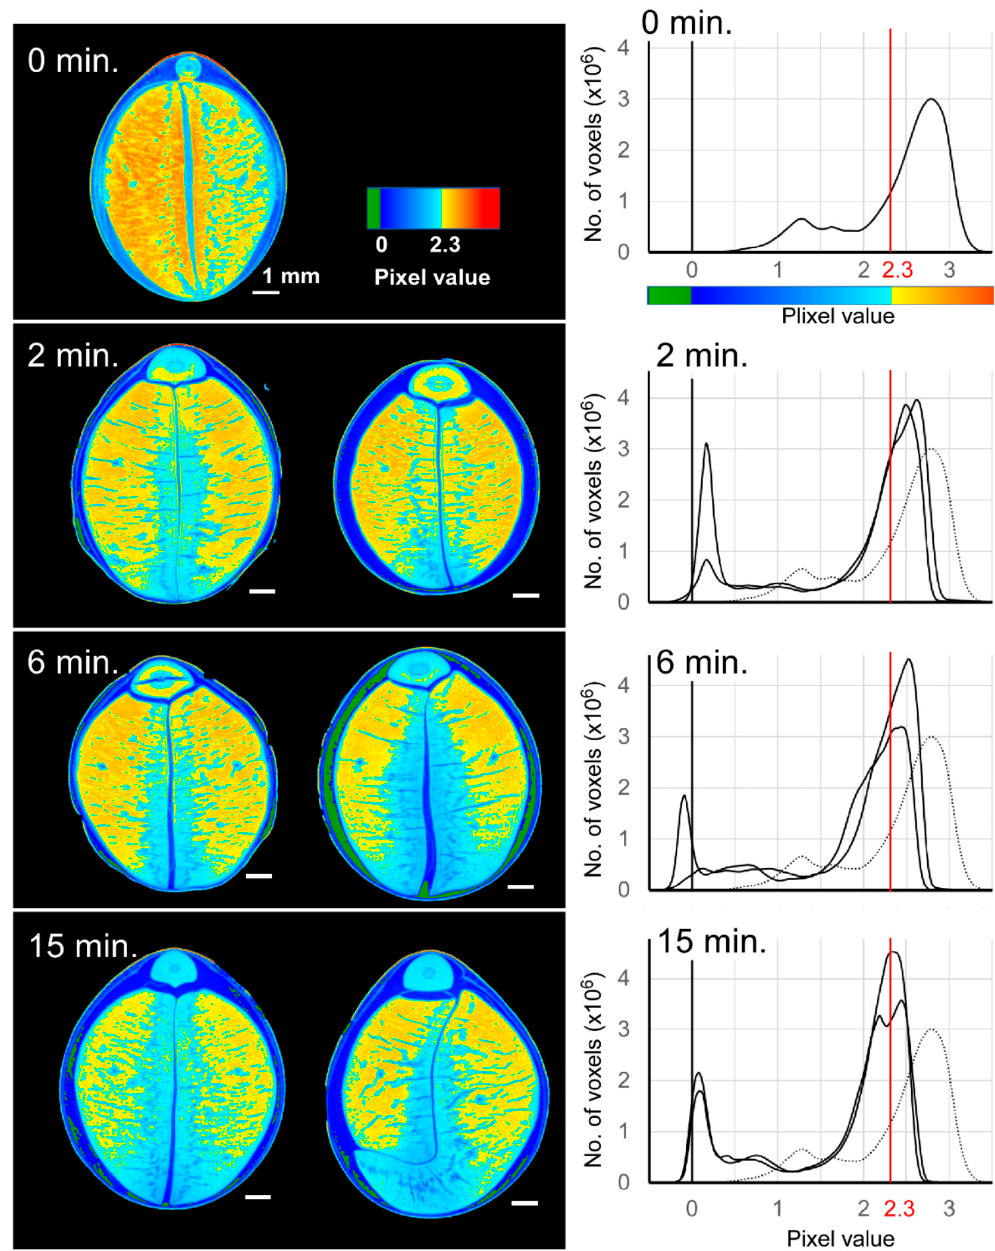
Figure 5. Tomogram images of edamame beans with different boiling times. ( Left ); Two samples are shown for boiling times of 2, 6, and 15 min. ( Right ); Frequency distribution of the pixel value of each voxel. In each histogram, the distribution of non-boiled samples is shown by the broken line.